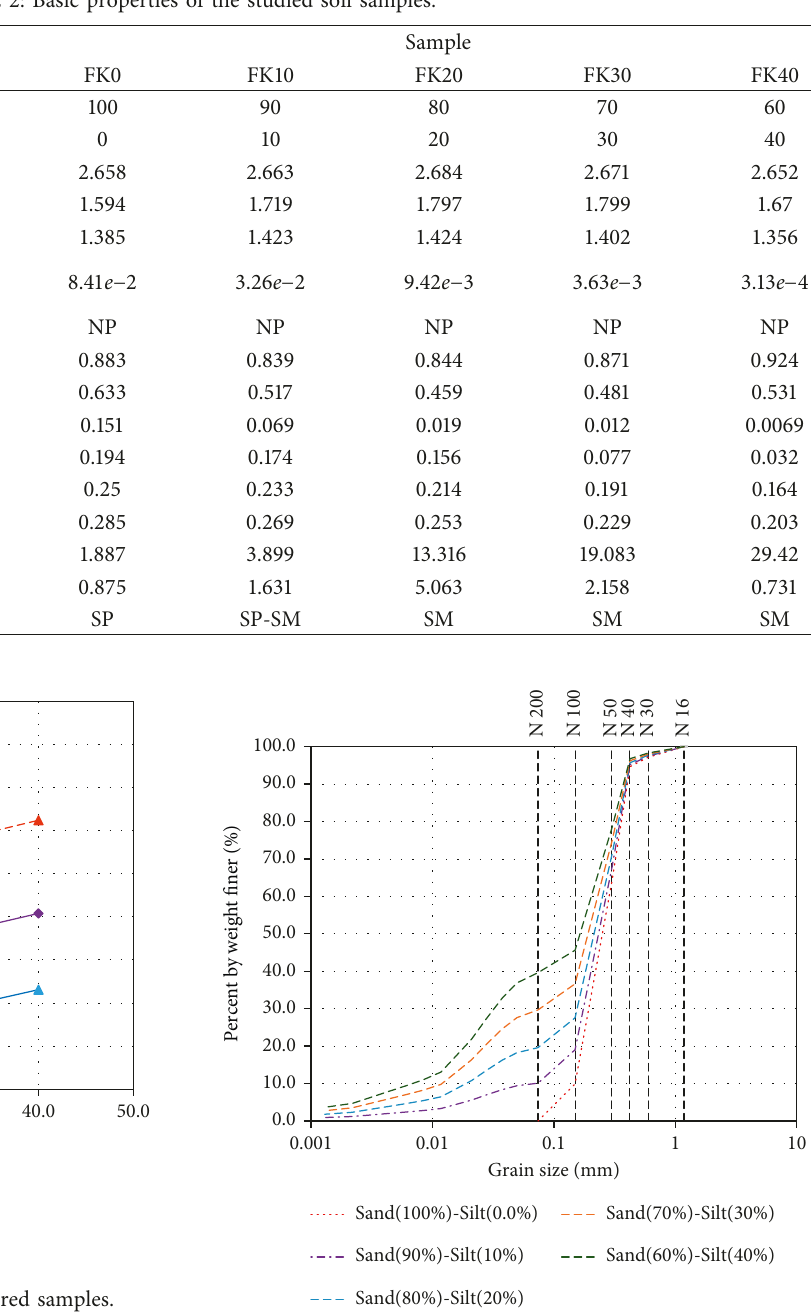
Figure 3: Grain size distribution of soil samples used in this